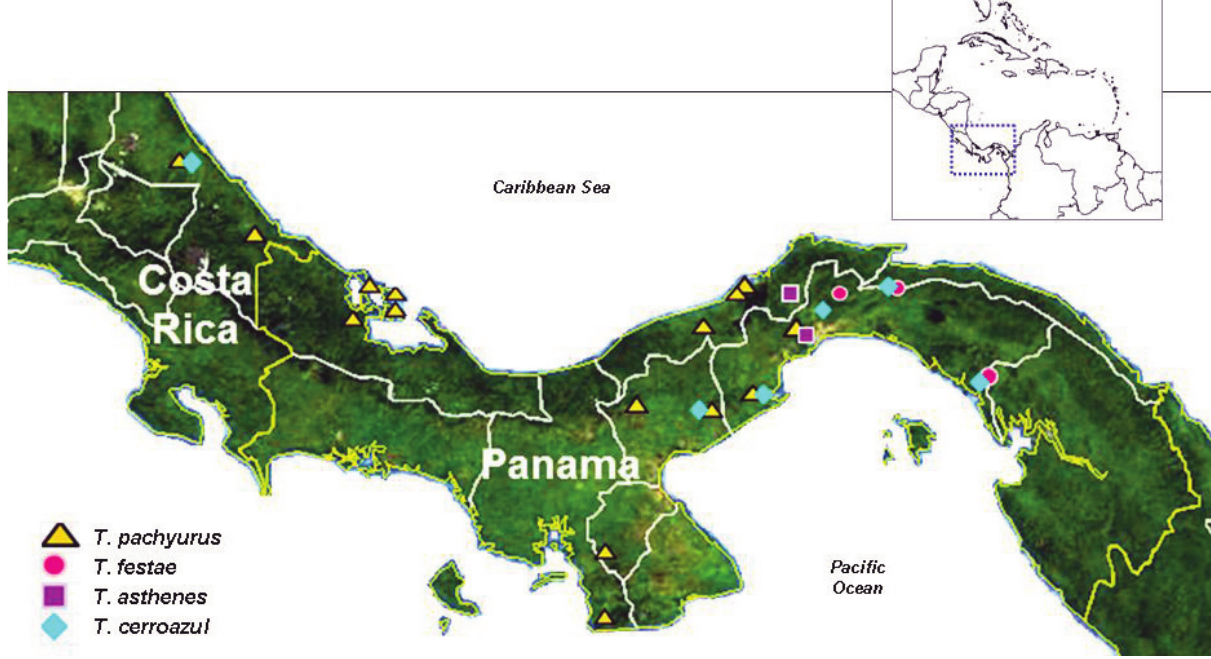
Figure 1. Geographical distribution of Central American Tityus species: The known distribution of T. asthenes, T. cerroazul, T. festae, and T. pachyurus in Panama and Costa Rica is presented with data taken from references 26, 27, 34-38, and 39. Unpublished data from R. Miranda, regarding additional collection localities for Tityus sp. in Panama are also